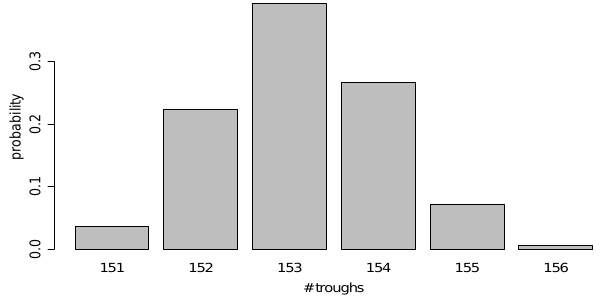
Fig. 13. Bar plot showing the probability distribution of the number of annual troughs – a summary of the chronology – in the dating of the Gomez core using its nss-S signal for ν 1 = 0 . 85, ν 2 = 0 . 5, and β =